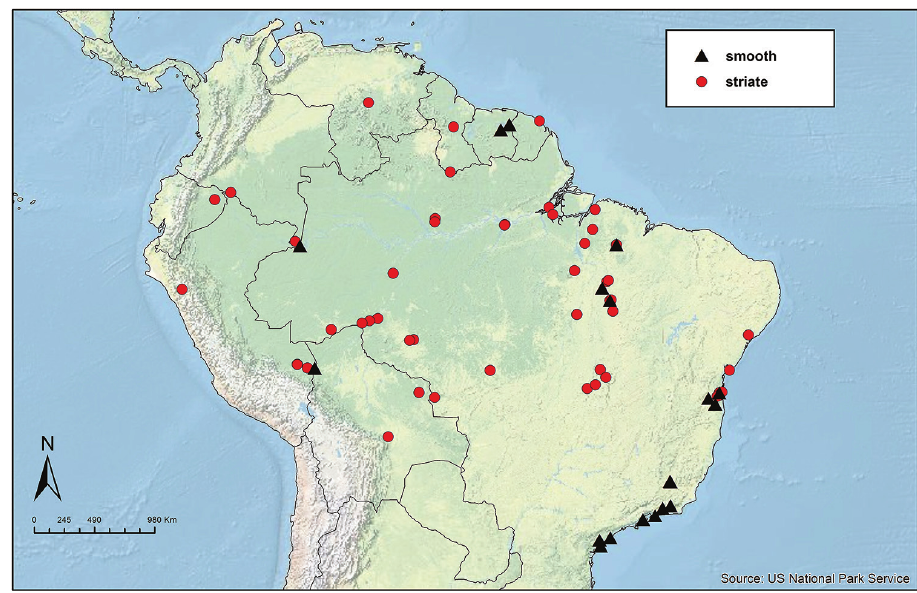
Figure 60. Distribution map of S. saussurei indicating smooth-mandibled (black triangles) and striate- mandibled (red circles)